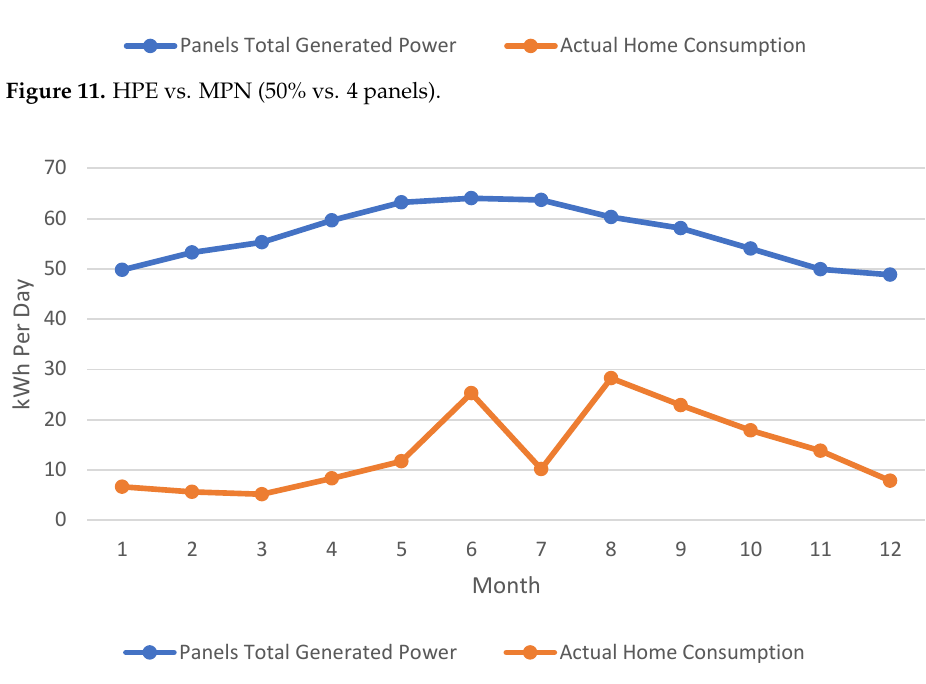
Figure 12. HPE vs. HPN (50% vs. 6 panels) . Generated to Consumed Electrical Energy Ratio (GtoC) is expressed in Equation (5).